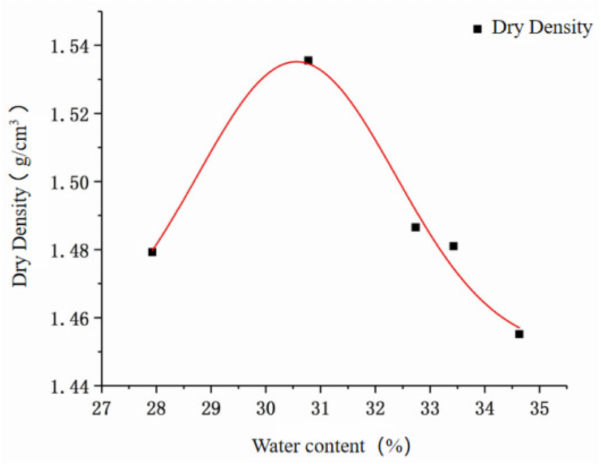
Figure 1. Combat curve. Table 1. Basic physical properties of red